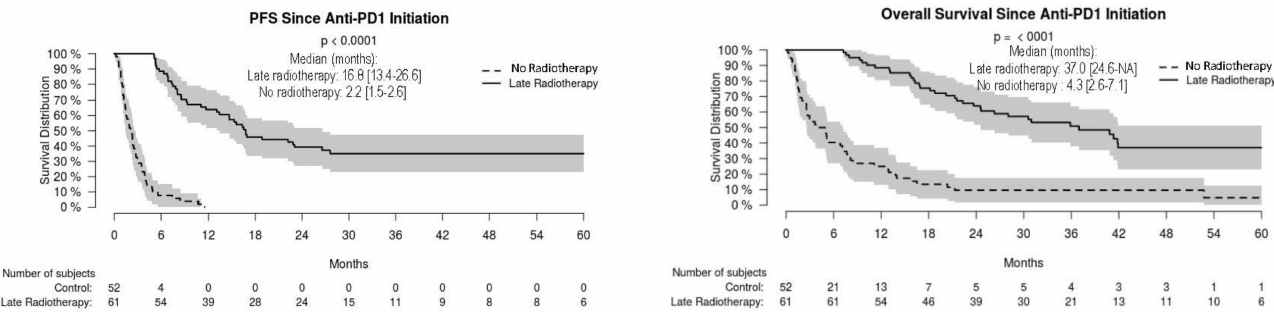
Figure 1. Progression-free (PFS) and overall (OS) survival in radiated and non-radiated anti-PD-1- treated melanoma patients.